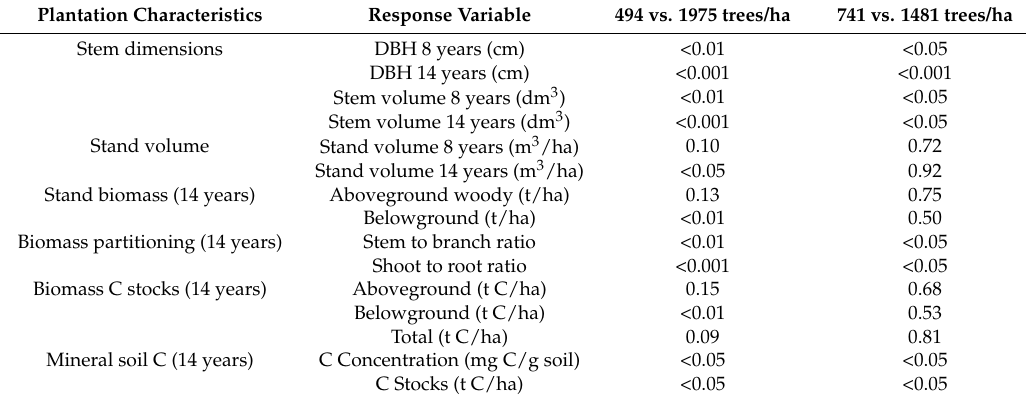
Table 4. Contrast probabilities ( p -values) between pairs of planting density treatments for different plantation characteristics in hybrid poplar